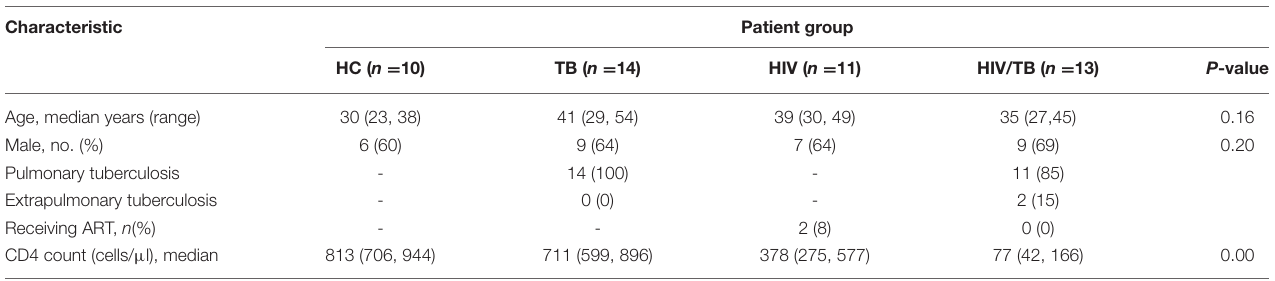
TABLE 2 | Clinical characteristics of individuals tested for cytokines and chemokine receptors.